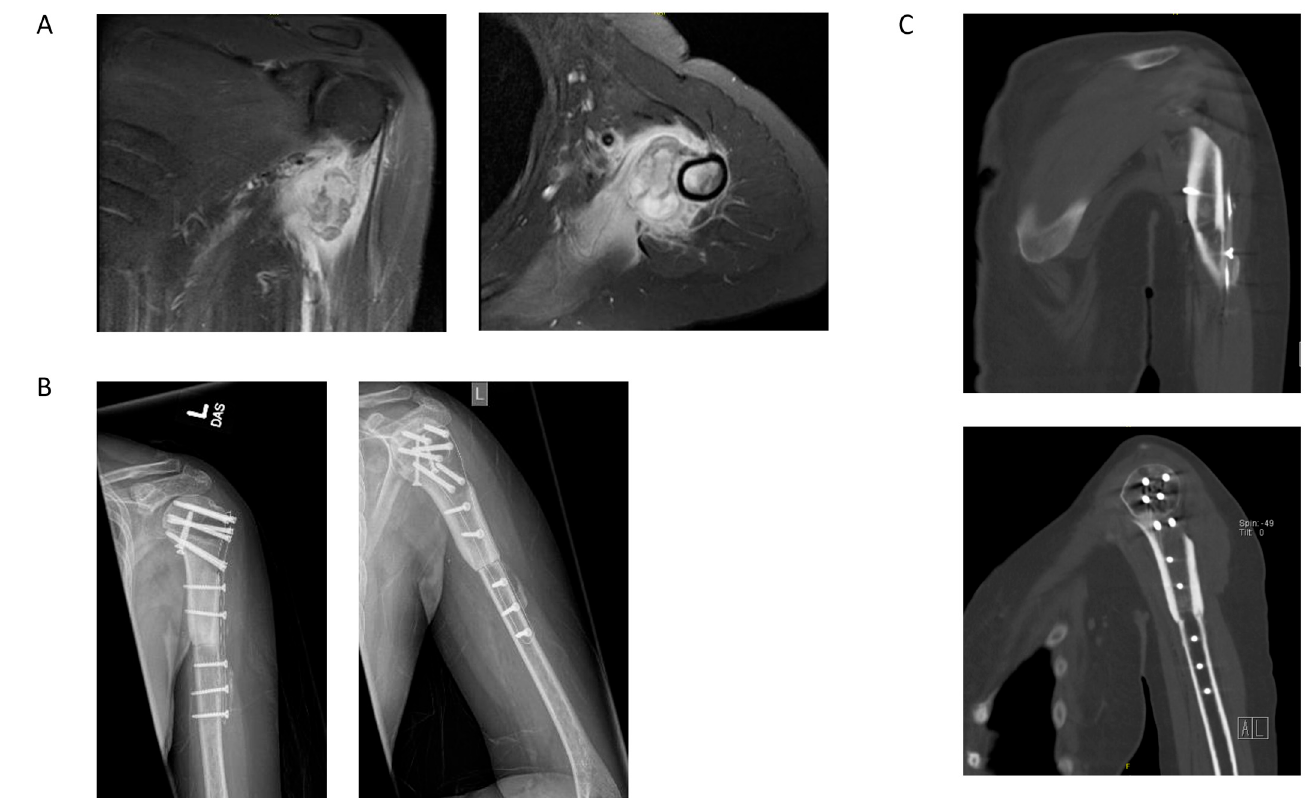
Figure 5. ( A ) Pre-operative T1 post-contrast, fat-saturation coronal and axial magnetic resonance (MR) images showing a large, enhancing tissue mass on the left proximal humerus without marrow involvement. ( B ) The 1-month post-operative AP and lateral radiographs following left humerus intercalary resection and allograft reconstruction with carbon fiber plate and cortical screws demonstrating incomplete fusion between the allograft and the native humerus. ( C ) The 8-month post-operative coronal and sagittal computed tomography (CT) images showing partial fusion. The carbon fiber plate facilitated visualization of the site of allograft and native humerus fusion status.